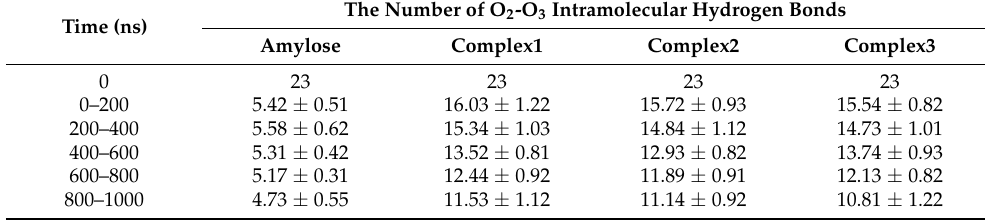
Table 1. The number of O 2 -O 3 intramolecular hydrogen bonds of amylose molecule in single-strand system and three amylose–zein complexes with different initial values.